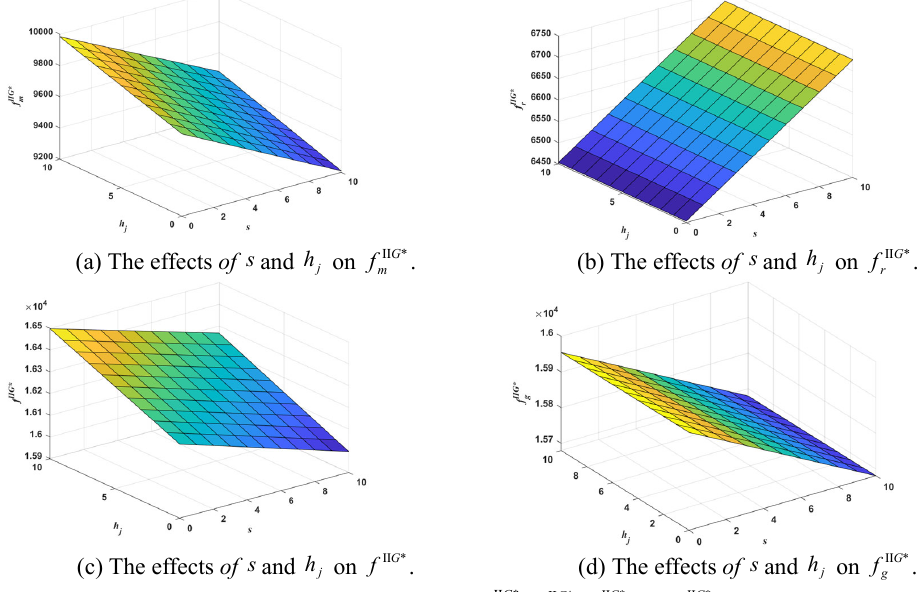
Fig. 13. The effects of s and